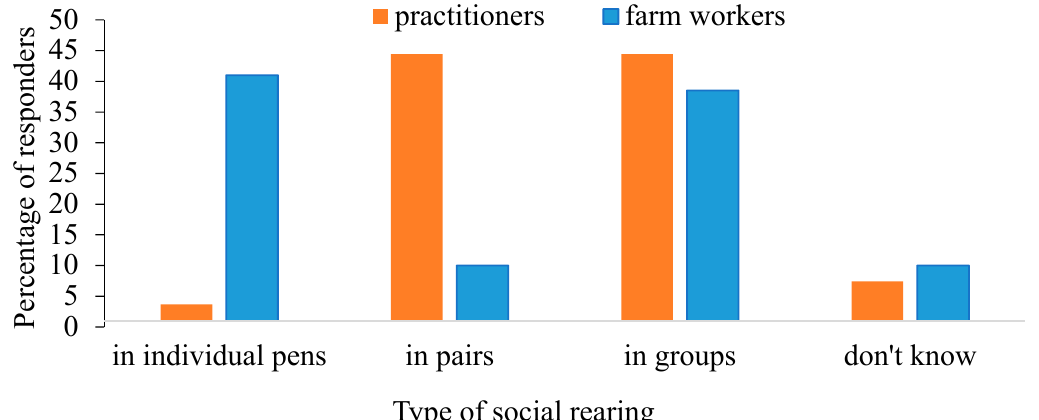
Figure 9. Distribution of practitioners’ ( n = 27) and farm workers’ ( n = 482) opinions regarding the preferred type of social rearing of pre-weaned calves (up to 2 months of age). There were no statistical differences among groups.